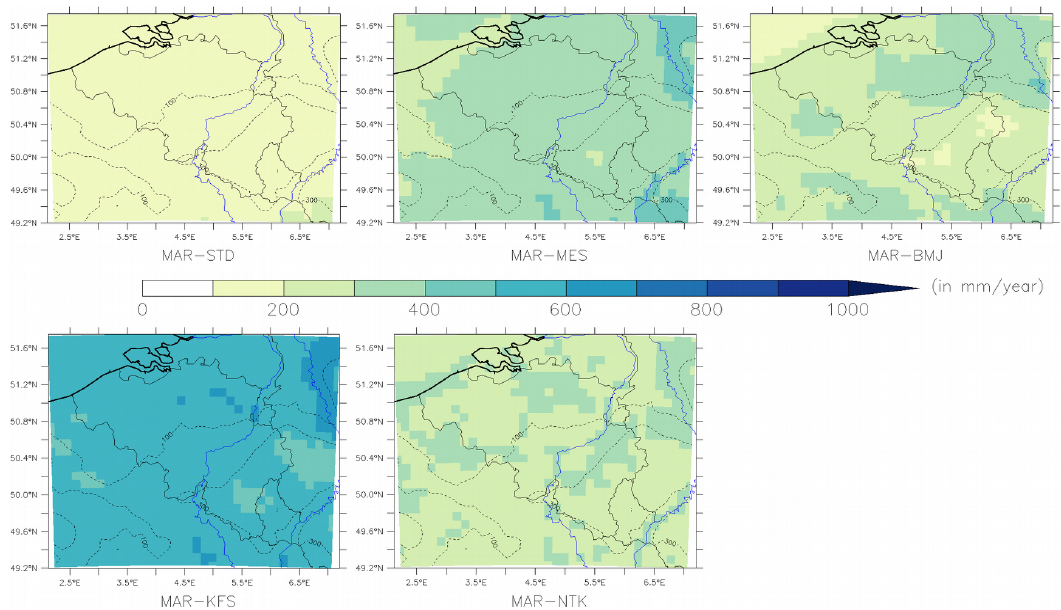
Figure 6. Mean annual convective precipitation over 1987–2017 simulated by MAR for each experiment in mm/year. Dotted black lines represent the 100 m and 300 m elevation of the MAR and the blue lines represent the major rivers of our studied area.